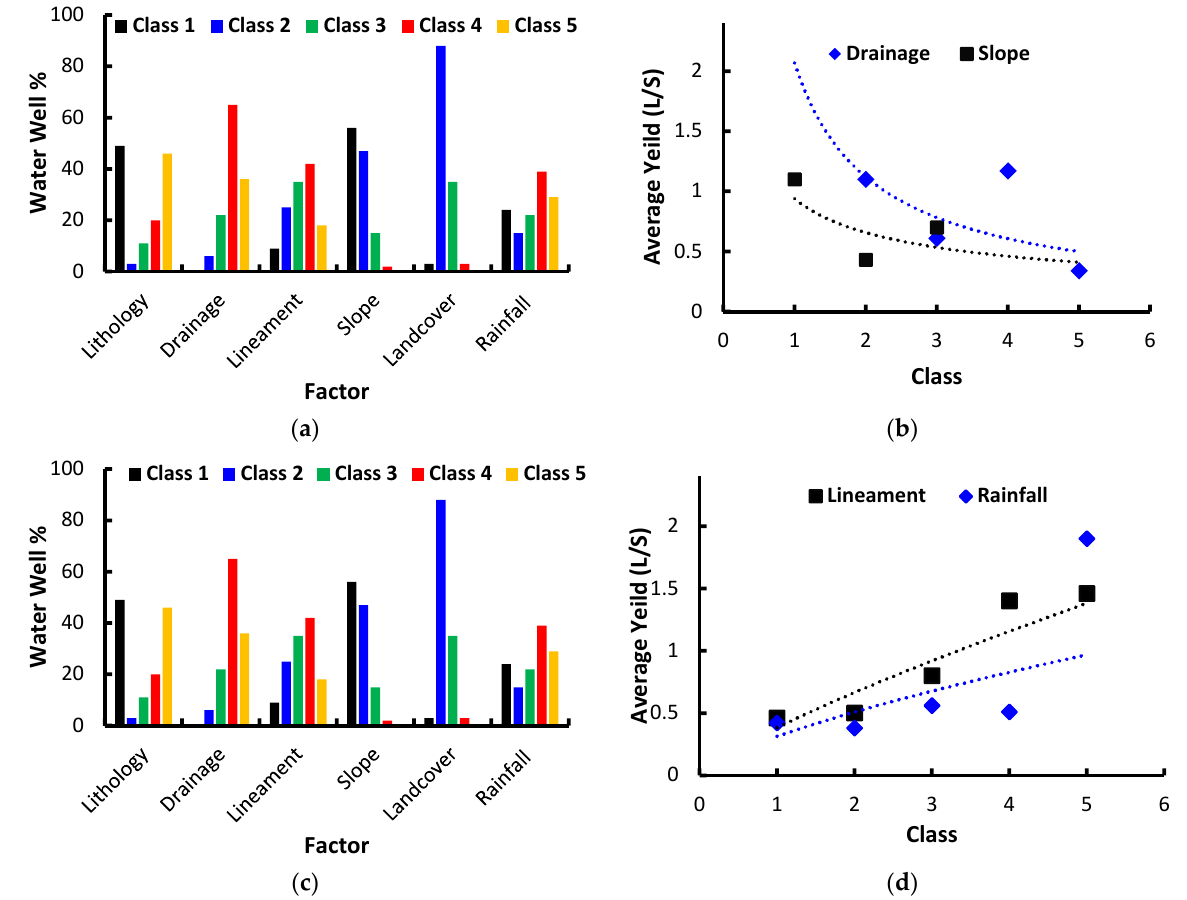
Figure 9. ( a ) Percentage of the water wells within the different classes of the influencing factors, ( b – d ) Average of the water yield against the classes of the influencing factors.